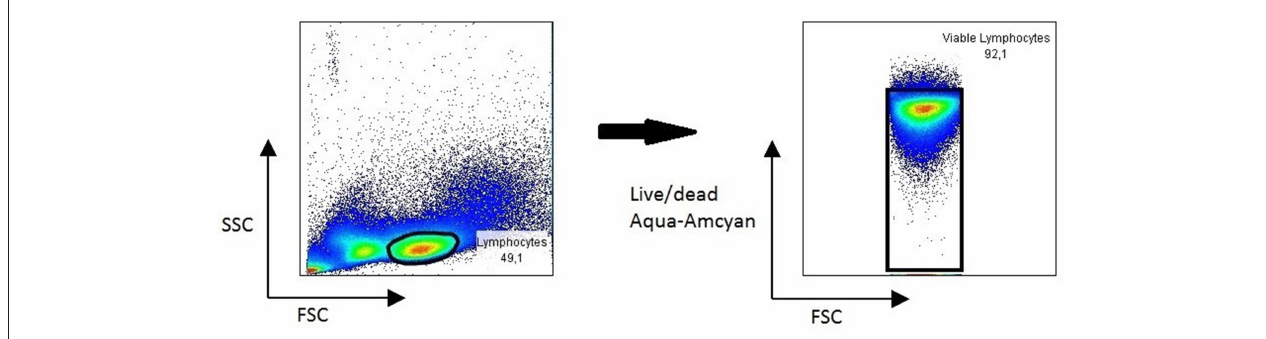
FIGURE 4 | Representative FACS plot showing viability of lymphocytes in PBMC 3 years after collection.